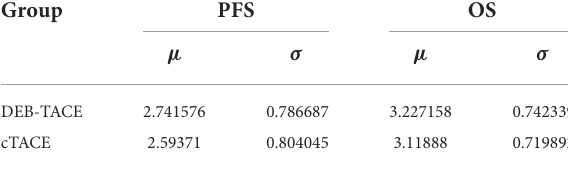
TABLE 2 Parameter values of Log-normal parameter distribution.